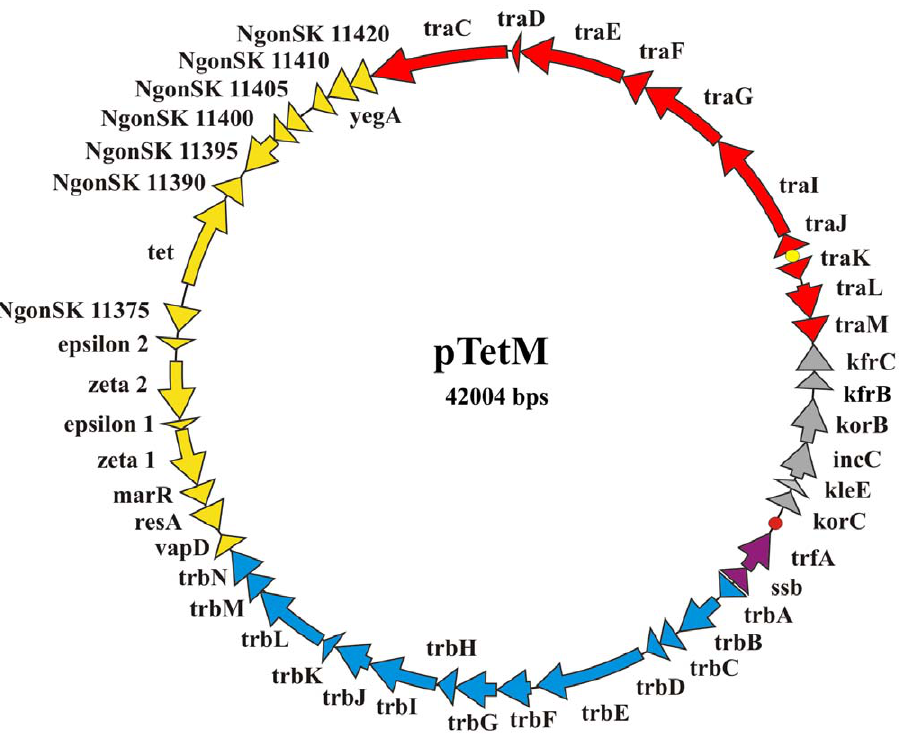
Figure 1. Circular map of the Neisserial conjugative plasmid (pEP5289) with the Dutch type tetM determinant and a Dutch type backbone. The open reading frames are colored as follows: red, conjugative transfer (tra); blue, mating pair formation (trb); purple, replication initiation (rep); grey inheritance/control (ctl) and yellow, genetic load. The origin of replication ( oriV ) and the origin of transfer ( oriT ) are indicated with red and yellow circles